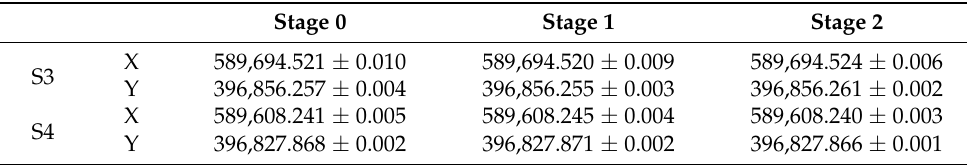
Comparative values of the coordinates and their very small deviations: Table A10. Comparative values of the coordinates.